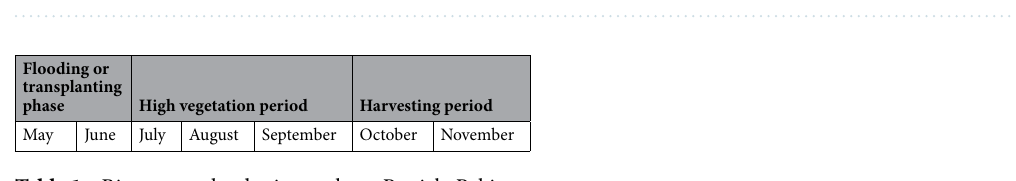
Table 1. Rice crop calendar in southern Punjab,